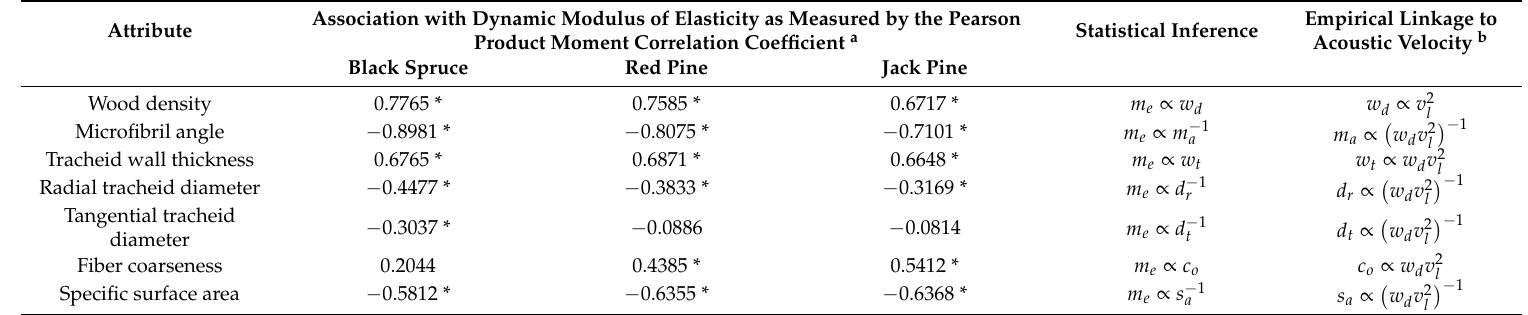
Table 2. Linear associations between the dynamic modulus of elasticity and other Silviscan-derived wood quality attributes for 3 boreal conifers and the resultant acoustic-based relationship